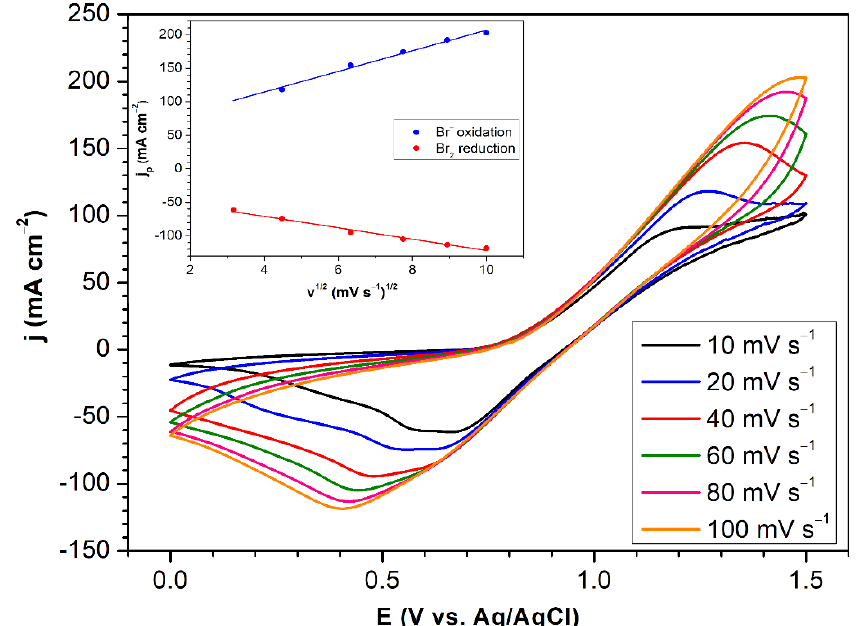
Figure 4. Cyclic voltammograms obtained at varying potential scan rates on an SGL 22AA carbon paper working electrode. Inset: plots of peak current density vs. square root of scan rate. 1 M HBr electrolyte, working electrode area 0.1 cm 2 . Temperature 25 ° C.